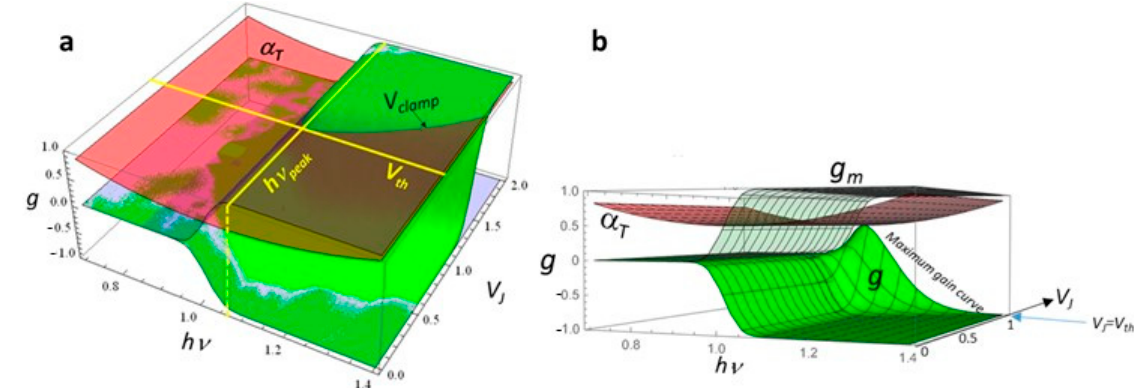
Figure 12. ( a ) Plot of the intersection of the gain g and loss α T surfaces; ( b ) the same plot, limited to the V J < V th range.